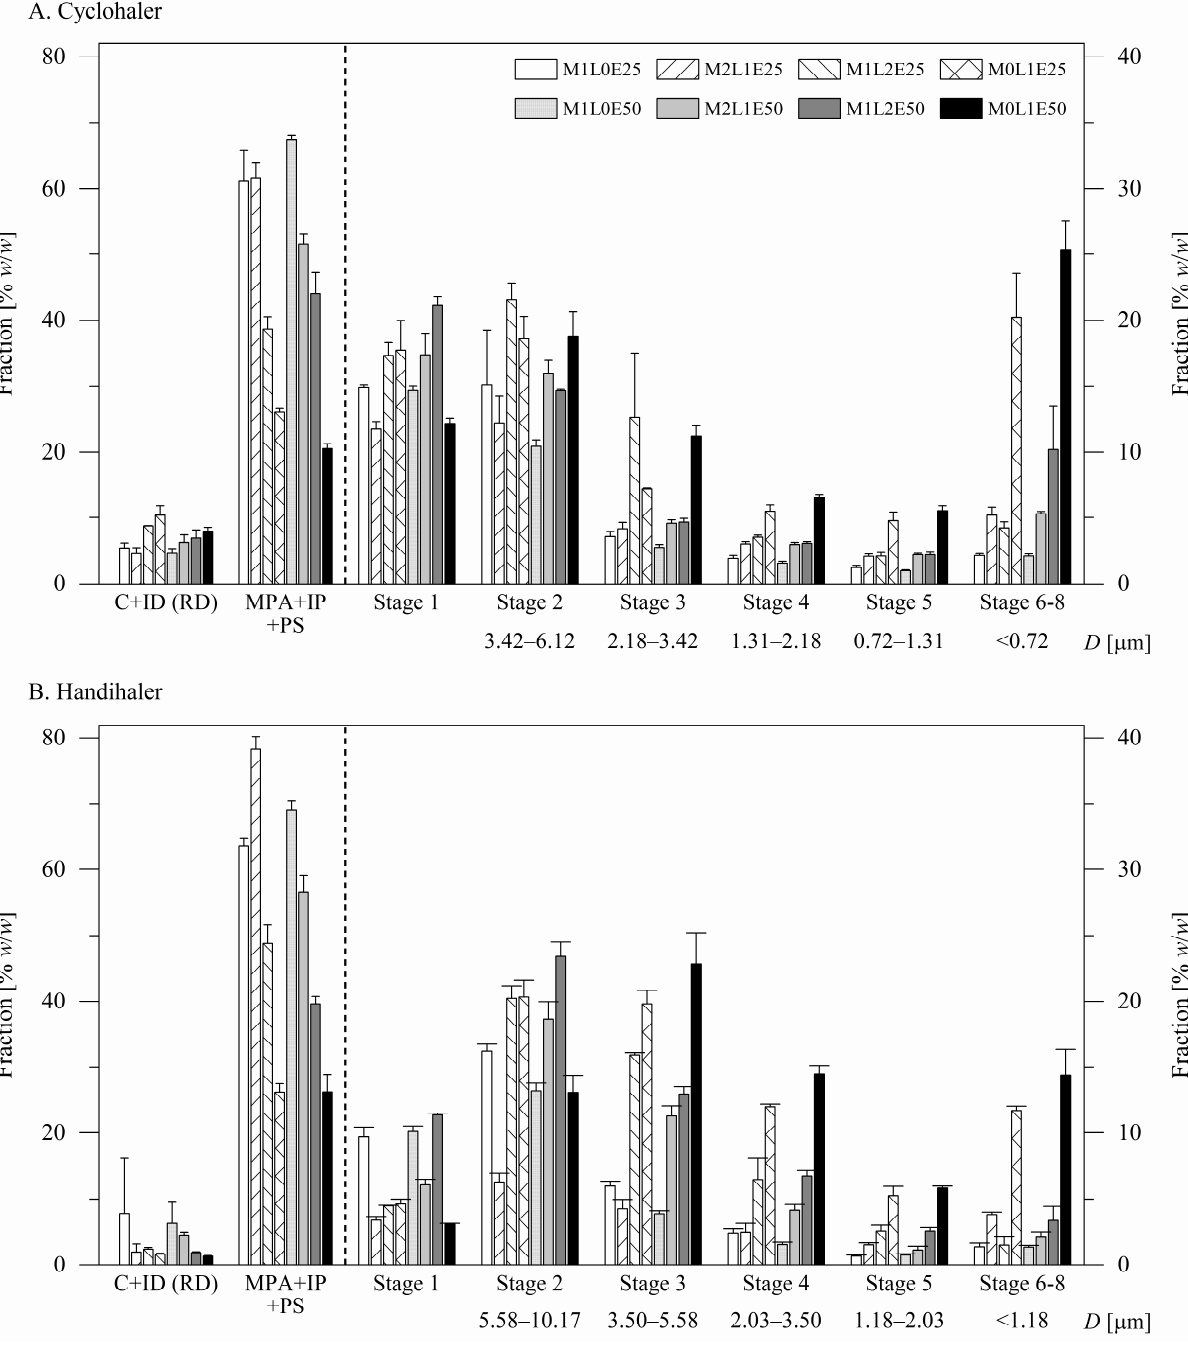
Figure 4. In vitro evaluation of the formulations by cascade impaction using ( A ) the Cyclohaler ® or ( B ) the Handihaler ® as an inhalation device. C+ID refers to the drug collected from the capsule shells and the inhalation device and is presented as a fraction of the recovered dose (left axis). MPA + IP + PS refers to the drug collected from the induction port, the mouthpiece adapter, and the preseparator and is presented as a fraction of the emitted dose (left axis). The drug collected from each of the impactor stages is presented as a fraction of the emitted dose (right axis). The size range of particles collected on each of the impactor stages is given to allow consideration of the impact of using different air flow rates for evaluation of the formulations using different inhalation devices.